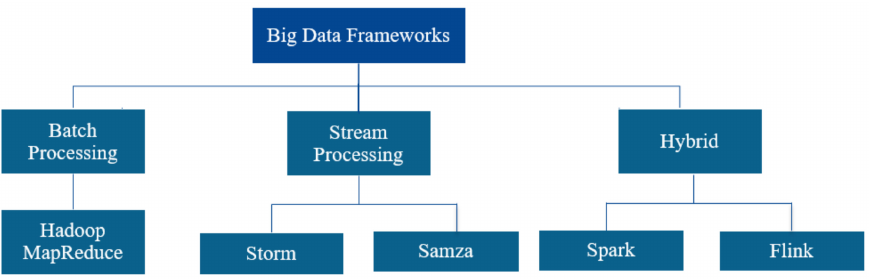
Figure 4. Classification of big data processing